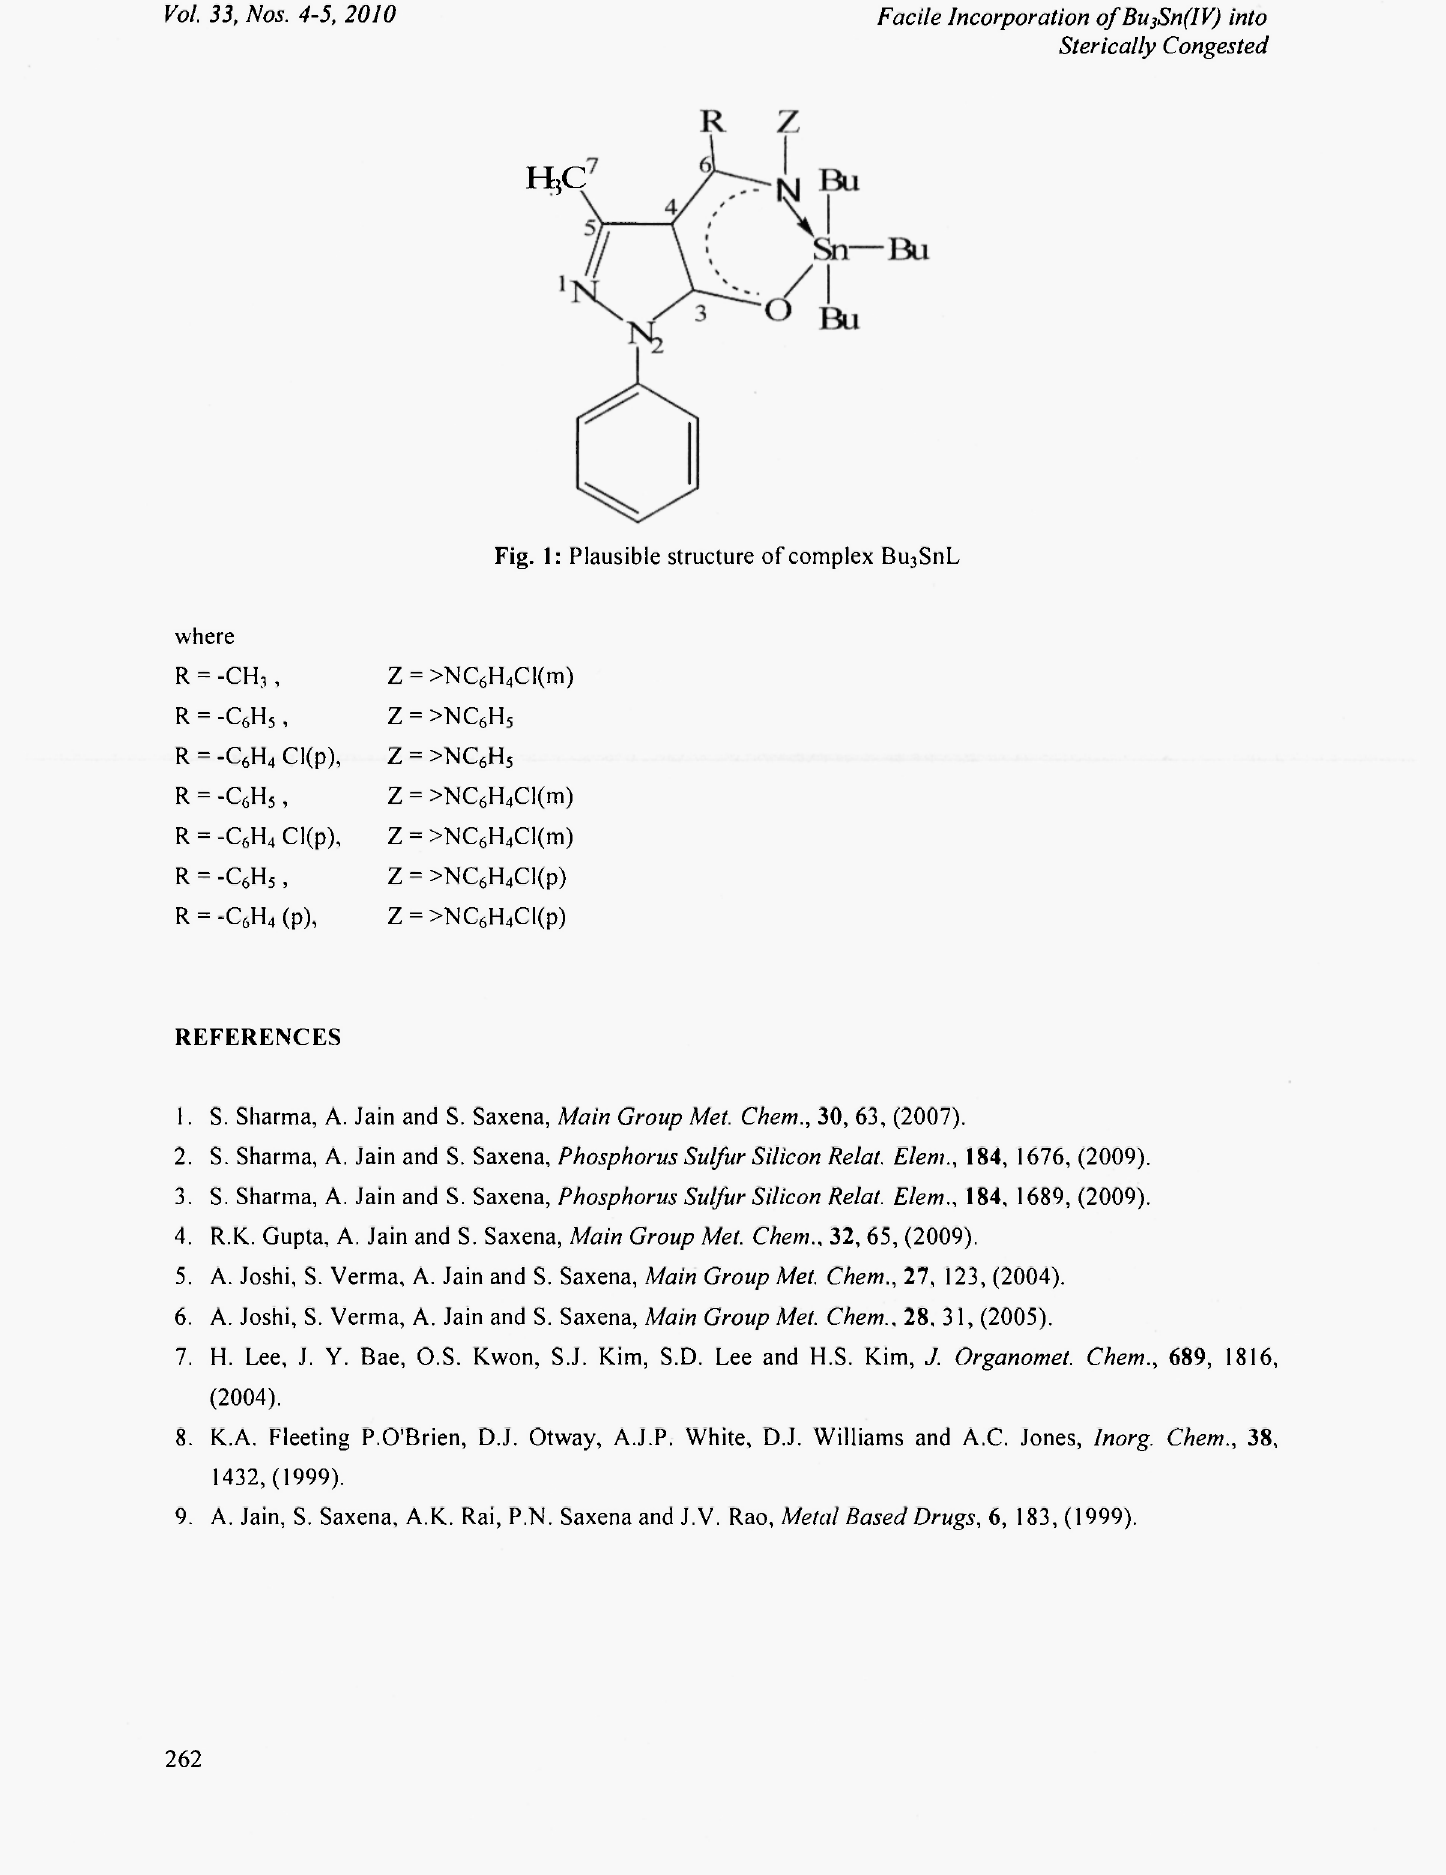
Fig. I: Plausible structure of complex Bu 3